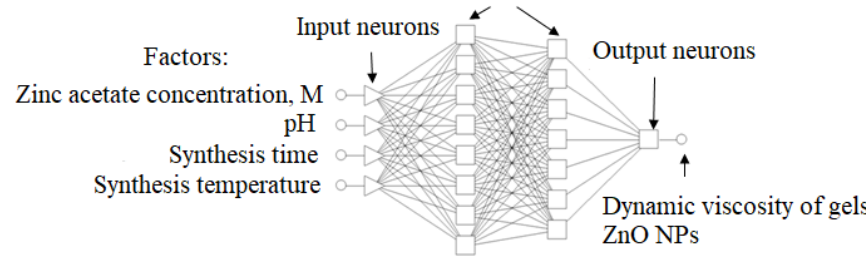
Figure 19. Multilayer